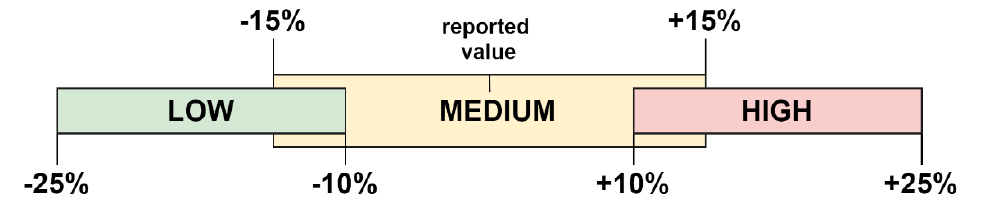
Figure 2. Adopted fuzzy ranges and corresponding deviations from the reported value.